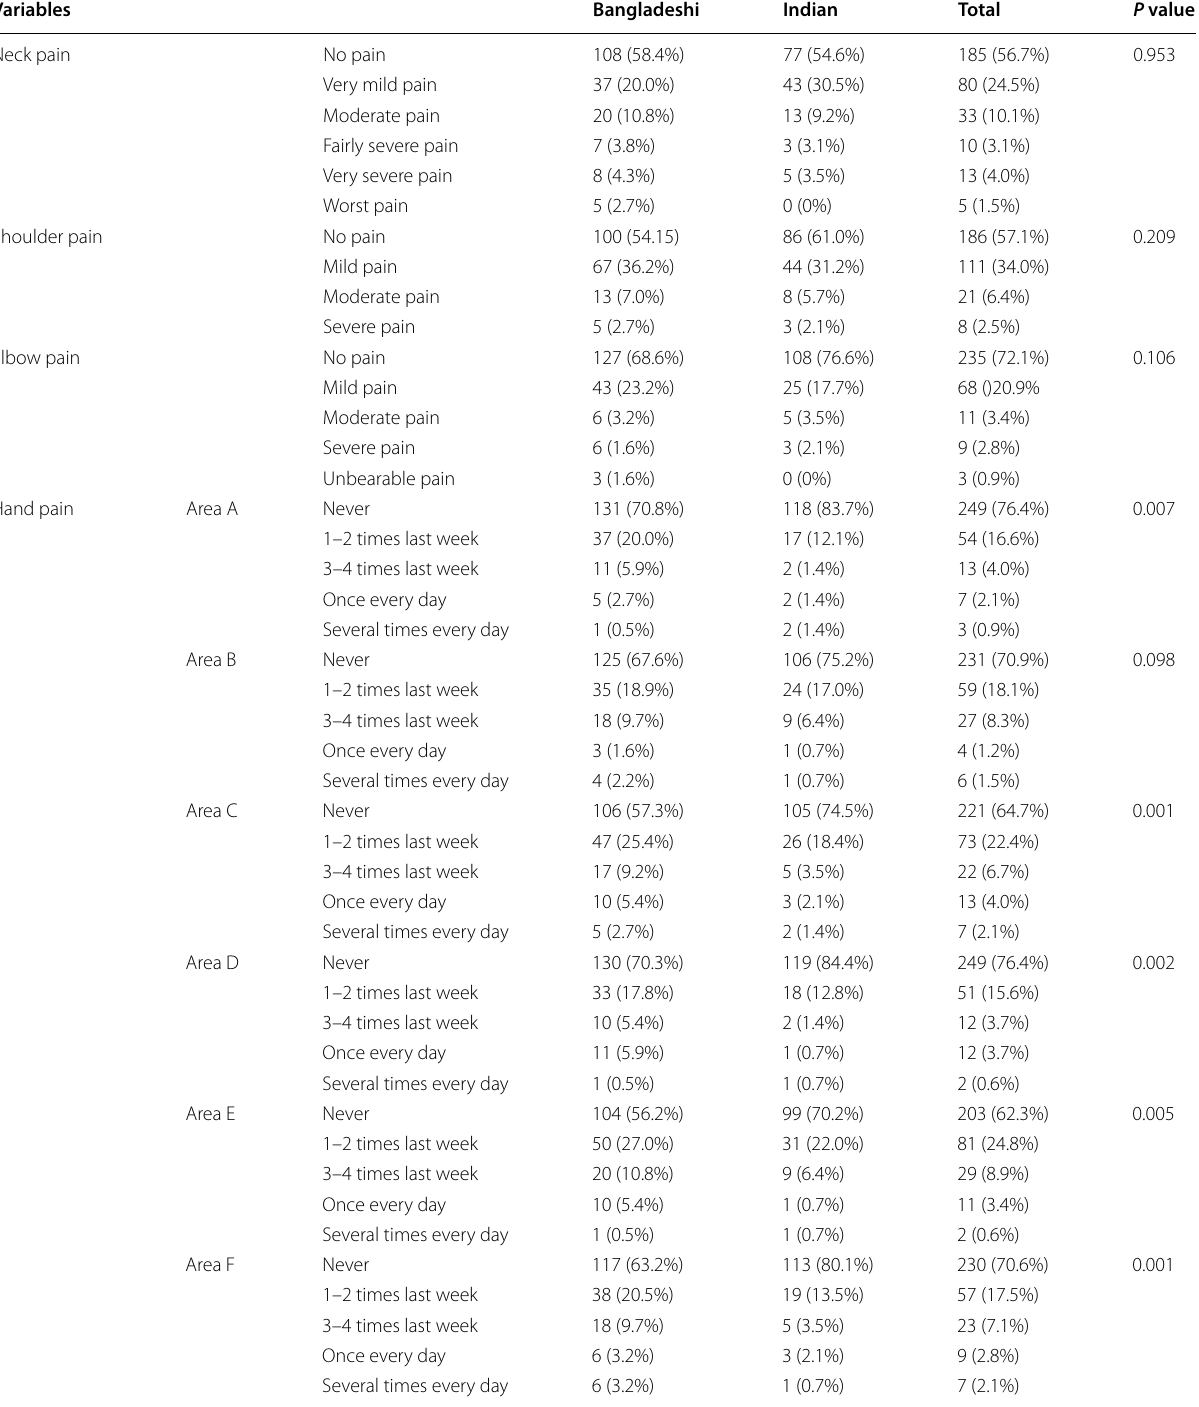
Table 2 Pain experience in neck, shoulder, elbow and shaded area of hand ( n